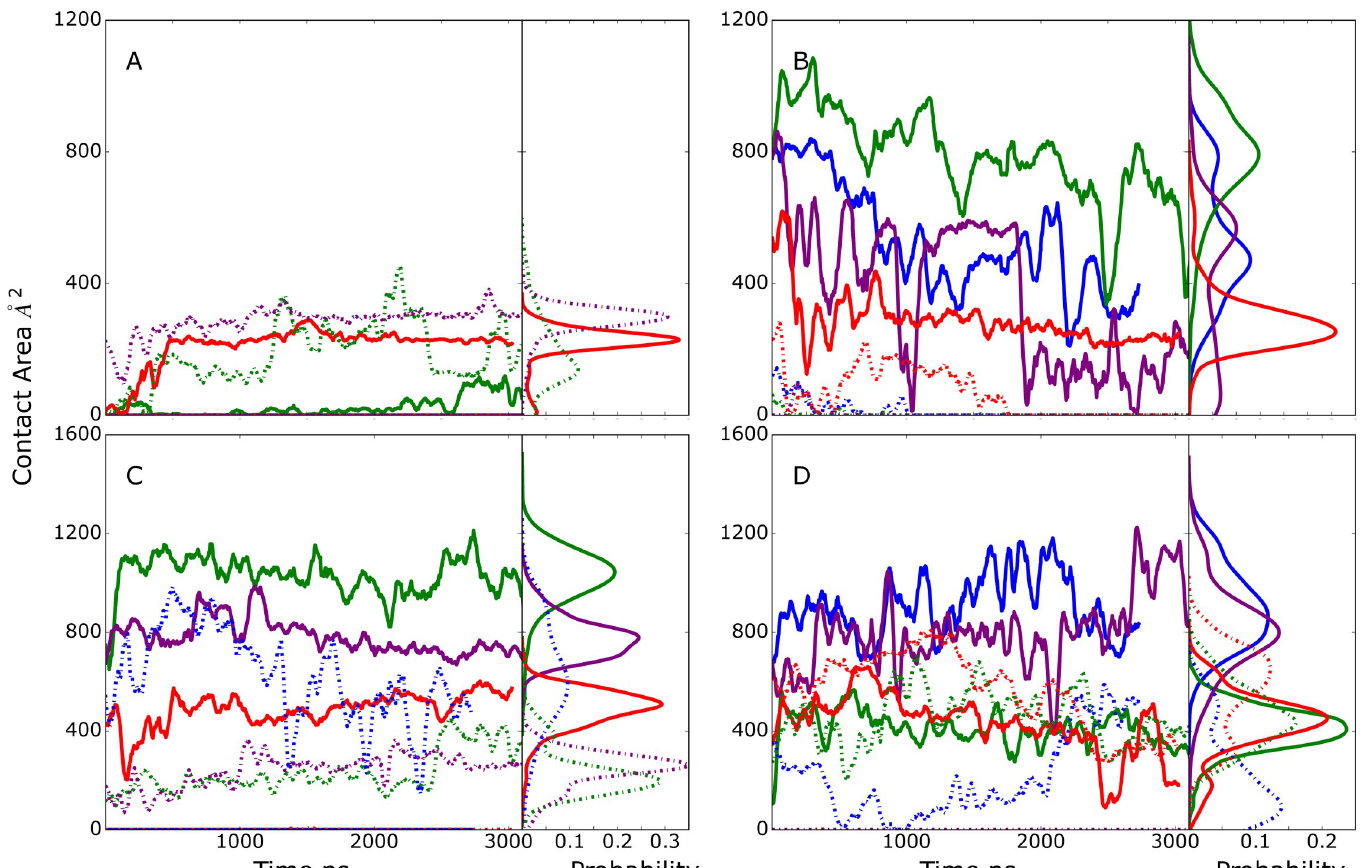
Fig 4. Model B time course and probability distributions of the contact area, Å 2 , between A) one of the Fc glycans (see below) and the CBM, B) the selected glycan of the Fc and the GH, C) the Fc protein CH2/CH3 domain hosting the selected glycan and the CBM and D) the Fc protein CH2/CH3 domain hosting the selected glycan and the GH during the MD simulations. Dark-solid lines represent selected glycan (A and B) or the Fc protein CH2/CH3 domain that hosts the selected glycan (panel C and D) and light-dashed lines represent second glycan that was not selected to interact with the GH (A and B) or the Fc protein CH2/CH3 domain that hosts the second glycan (C and D). Results shown for individual MD simulations 1) blue, 2) green, 3) purple and 4) red. Data is presented as a 50 ns moving